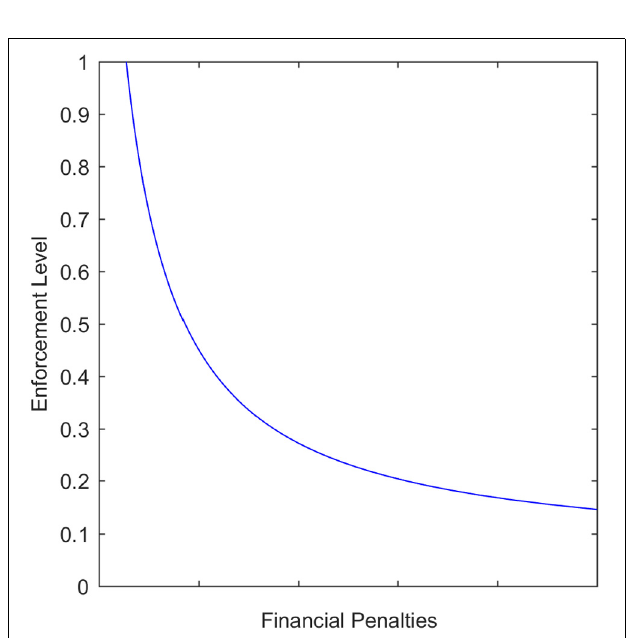
FIGURE 4 | C g − B g < 0 regulatory agencies’ evolutionarily stable strategy.